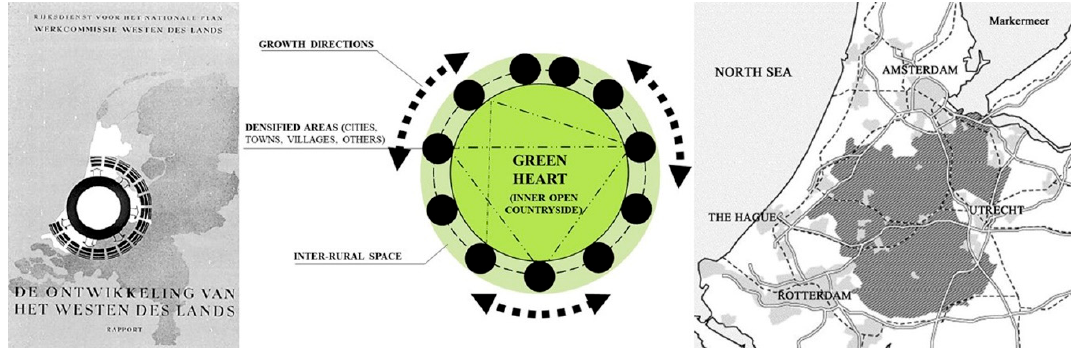
Figure 3. Map and diagrams of Randstad zone. ( left ) The original plan illustrating the “ring-city”. ( middle ) An abstraction of the general urban form composed of the urbanized ring and the “Green-Heart”. ( right ) Map of the Randstad zone (Author’s image).